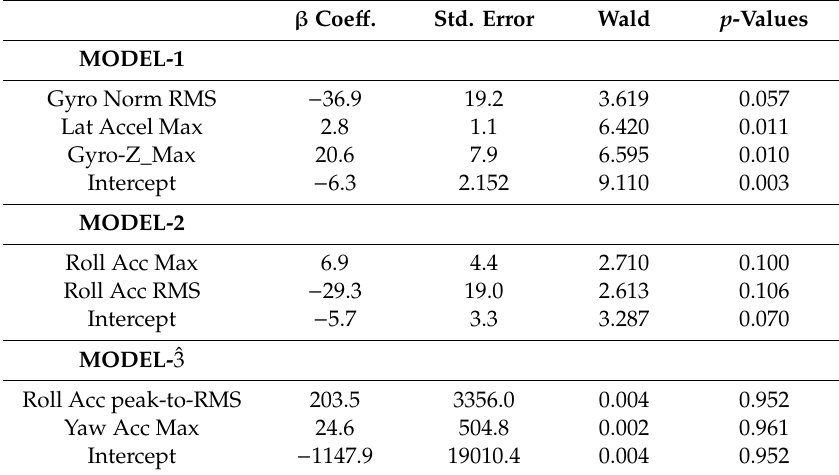
Table 1. Logistic Regression Analysis of 165 braking trials for loss of control cases classification. β Coe ff . Std. Error Wald p